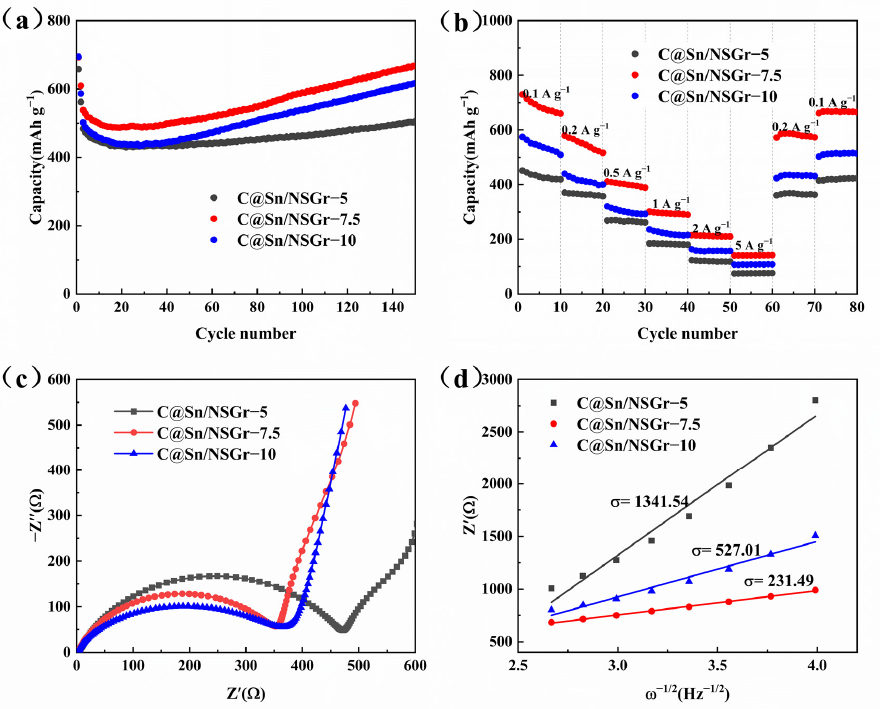
Figure 6. Cycle performances at the current density of 0.1 A g − 1 ( a ), rate performances ( b ), Nyquist plots for electrochemical impedance spectra ( c ), relation of the Z ′−ω − 1/2 curves in the low − frequency region ( d ) of C@Sn/NSGr − 5, C@Sn/NSGr − 7.5 and C@Sn/NSGr − 10.